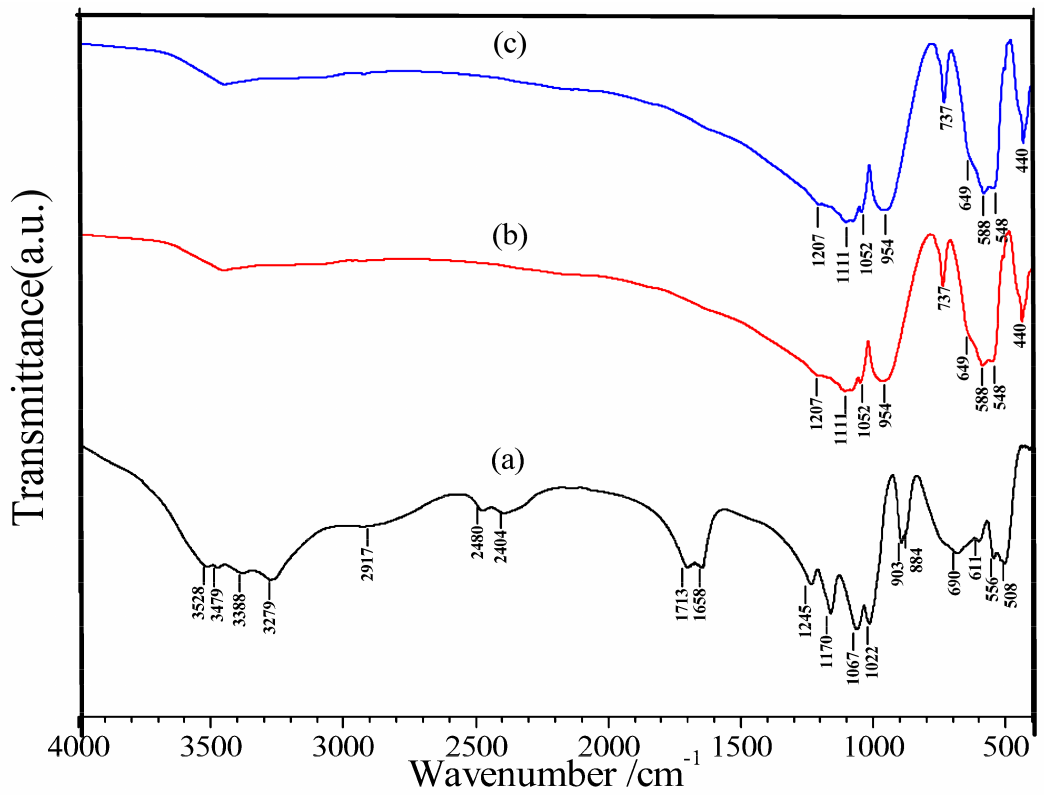
Figure 2. FTIR spectra: ( a ) the synthesized hydrate, ( b ) the calcined products at 773 K, and ( c ) the calcined products at 973